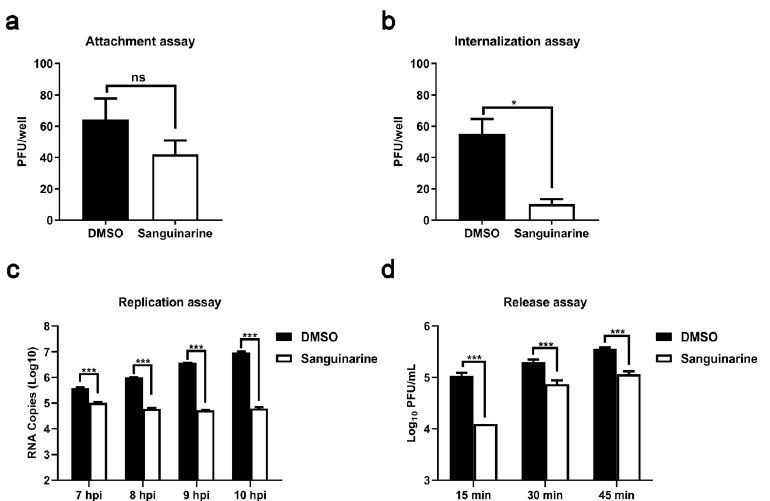
Figure 4 . Sanguinarine exhibits anti-PRRSV properties by multisite inhibition mechanisms. MARC- 145 cells were incubated with sanguinarine (0.80 µ g/mL) and PRRSV as described in 2.10 ( a ), 2.11 ( b ), 2.12 ( c ), and 2.13 ( d ) of the Section 2. Data are expressed as the means and standard deviations from three independent experiments and analyzed using two-tailed Student’s t -test ( a , b ) or two-way ANOVA ( c , d ). *, 0.01 ≤ p < 0.05; ***, p < 0.001. ns, no significance.